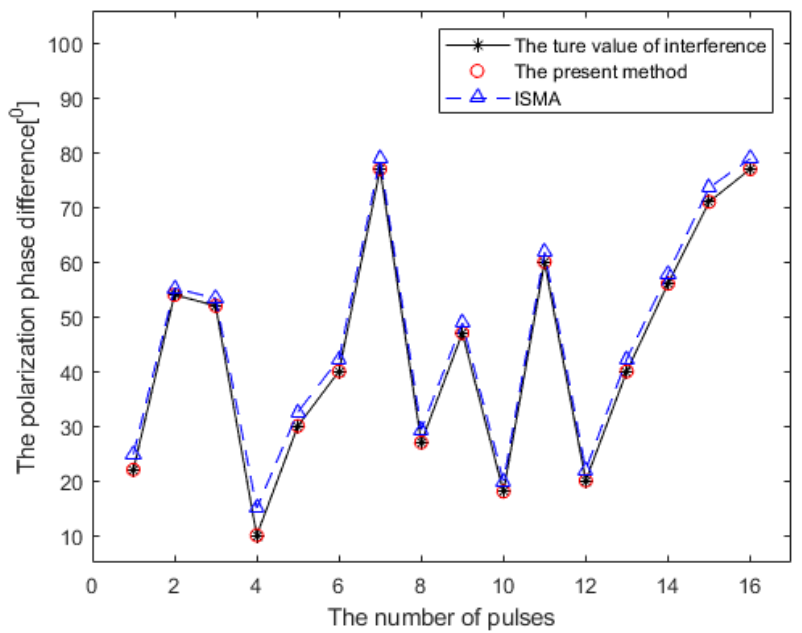
Figure 13. The estimation of these two methods under ISR 2 = 40